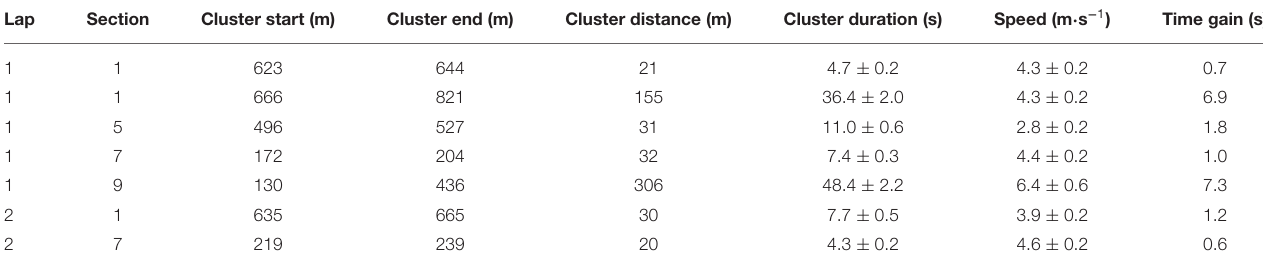
TABLE 2 | Characteristics of the SPM clusters where section time was significantly related to instantaneous speed for the women, with mean ± standard deviation time, velocity and time gain (i.e., the time difference between the fastest and slowest skier) for each